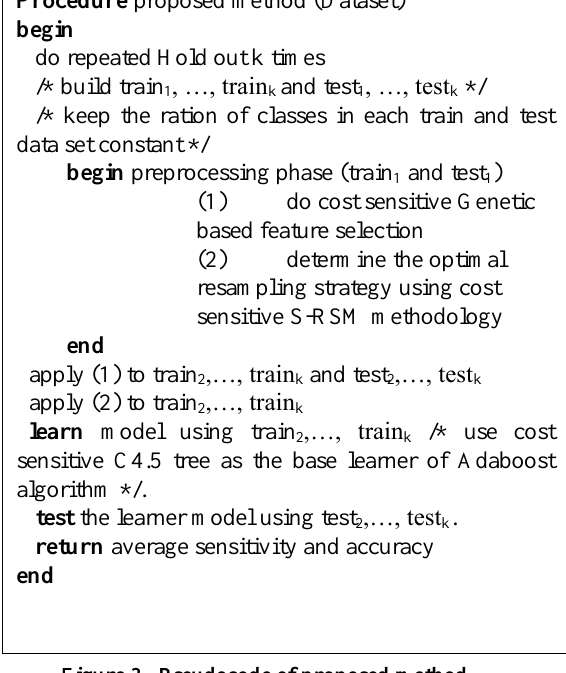
Figure 3. Pseudocode of proposed method. Table 9. Comparison of the